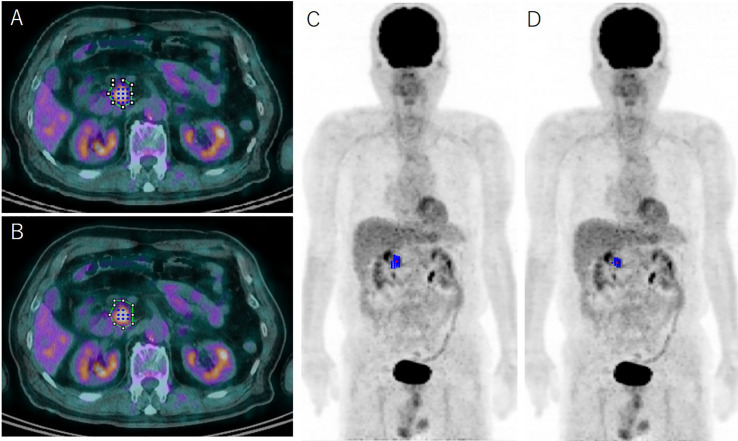
Representative case determined using the absolute 2.5 threshold method (A, C) and the relative 41% threshold method (B, D) with representative axial 18F-fluorodeoxyglucose-positron emission tomography (FDG-PET)/computed tomography fusion images and 3D reconstructed FDG-PET images. The green line on the axial images (A, B) indicates the initial volume of interest for determining metabolic parameters of pancreas ductal adenocarcinoma on FDG-PET; the blue dots and lines show the identical metabolic tumor volume (MTV) using the absolute 2.5 method (A, C) and the relative 41% method (B, D), respectively. The MTV is grossly underestimated using the relative 41% method compared with the 2.5 method.